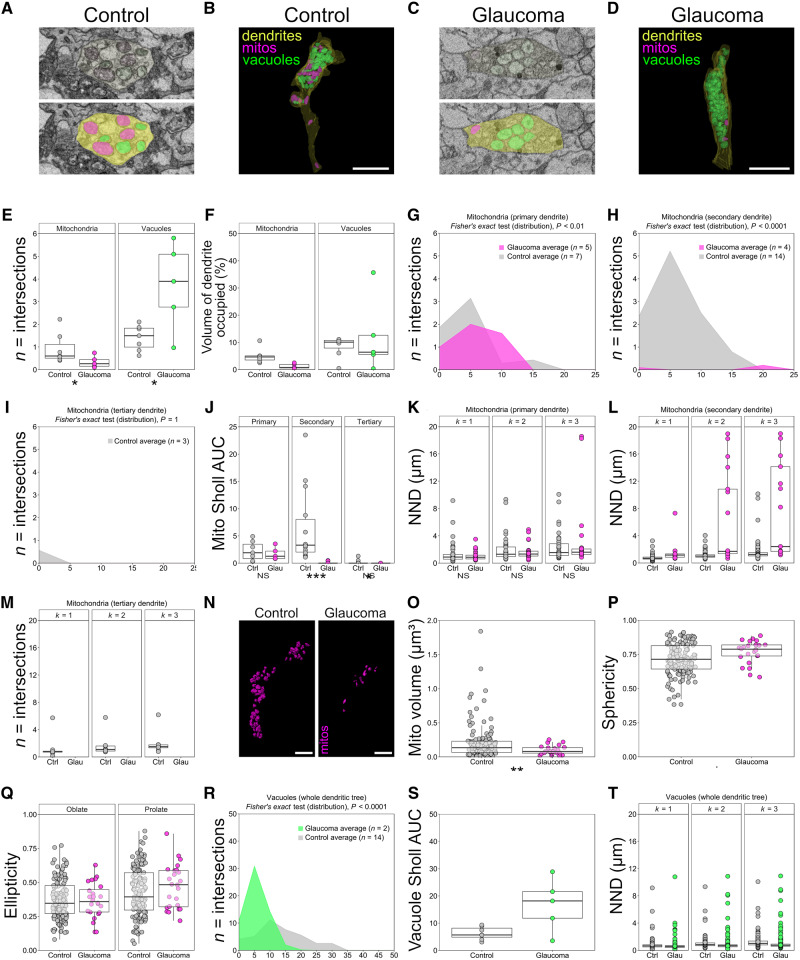

Mitochondrial morphometry and distribution are altered in human glaucoma. Organelles from five glaucomatous (n = 4 eyes) and seven control retinal ganglion cells (n = 4 eyes) were reconstructed in FIJI (ImageJ). Mitochondria (mitos, magenta; identified by the presence of cristae; n = 198 in controls, n = 55 in glaucoma across all cells analysed) and vacuoles (green, double membranous structures devoid of cristae and electron dense material; n = 273 in controls, n = 326 in glaucoma across all cells analysed) were reconstructed within retinal ganglion cell dendrites (yellow). Representative EM images for control (A) and glaucoma (C) and reconstructions (B and D) are shown. The number of mitochondria per micrometre of dendrite for individual retinal ganglion cells was reduced in glaucoma (E), and mitochondria occupied a reduced percentage of dendritic volume in glaucoma compared with controls (F). Sholl analysis of mitochondria demonstrates that the mitochondrial distribution across dendrites was altered in glaucoma when expressed as a distribution statistic for primary dendrites (G; ‘Fisher’s exact’ test; for individual dendrites, n displayed in figure), secondary dendrites (H; ‘Fisher’s exact’ test) but not tertiary dendrites (I; ‘Fisher’s exact’ test). When expressed as Sholl AUC (J), mitochondrial distribution is significantly changed in secondary dendrites in glaucoma compared with controls but not for primary and tertiary dendrites. NND analysis demonstrated no significant change in the proximity of mitochondria to one another in primary dendrites (K; mitochondria n = 39 in controls, n = 38 in glaucoma) but a significant isolation in secondary dendrites [distances to the first, second and third nearest neighbours (k = 1–3) increased; L; mitochondria n = 151 in controls, n = 17 in glaucoma]. There were no observable mitochondria in tertiary dendrites in retinal ganglion cells from glaucoma eyes (M). Individual mitochondrial surface reconstructions were generated in Imaris (mitochondria n = 149 in controls, n = 55 in glaucoma), and representative images are shown for control and glaucomatous retinal ganglion cells (N). Mitochondria demonstrated significantly reduced volumes in glaucoma (O) and were more spherical compared with controls (P). Oblate (rounded) and prolate (cigar-shaped) ellipticity was not significantly altered (Q). Sholl analysis of vacuoles across the dendritic tree as a whole demonstrated a significant change in distribution (R; ‘Fisher’s exact’ test) but not in the Sholl AUC (S). The number of vacuoles per micrometre of dendrite was increased in glaucoma (E), but the percentage of dendritic volume occupied by vacuoles was unchanged (F). Nearest neighbour distances in vacuoles for the k = 3 nearest neighbours decreased significantly in glaucoma indicating an increased density of vacuoles (T; vacuoles n = 273 in controls, n = 326 in glaucoma). *P < 0.05, **P < 0.01, ***P < 0.001, NS = non-significant (P > 0.05). Scale bar = 5 μm for B and D and 3 μm for N.